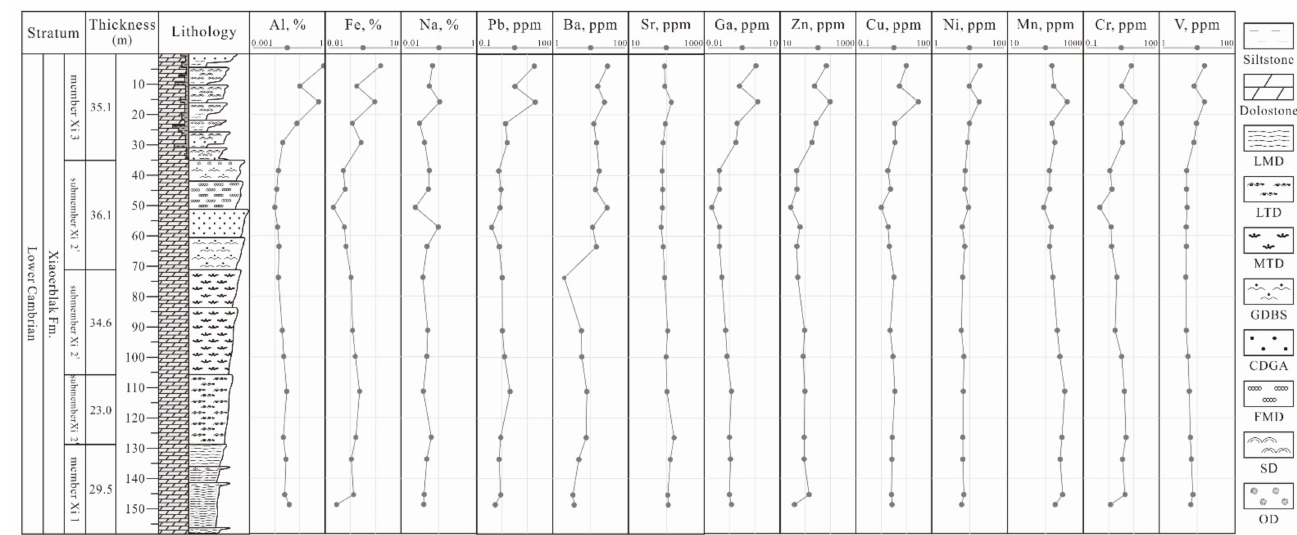
Figure 6. Geochemical variation tendency of Trace elements in Xiaoerblak Formation